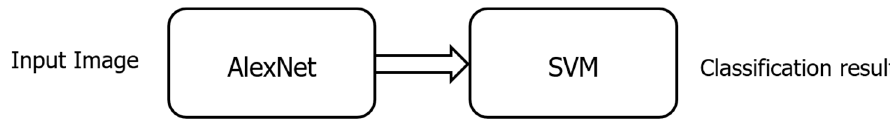
Figure 8. Block diagram of the system for feature extraction and one-class classification.